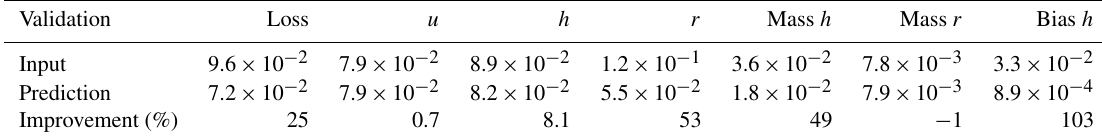
Table 2. The same as Table 1 but for dT10 η = 2 .